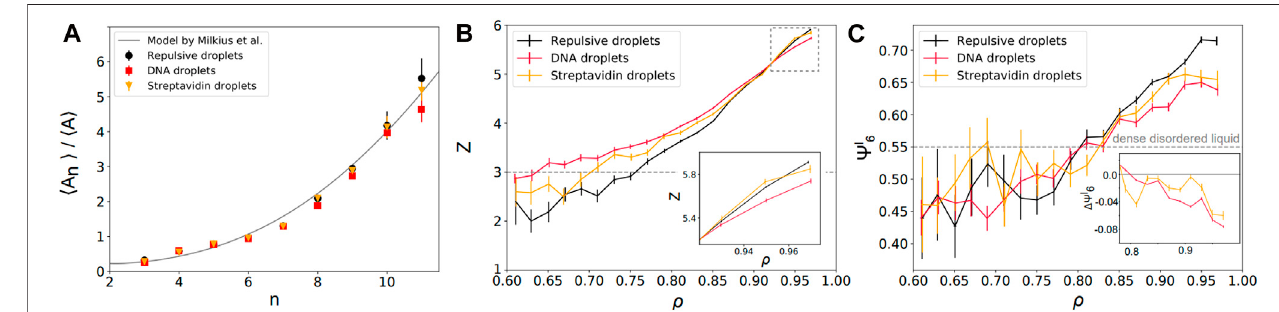
FIGURE3| Localstructuralpropertiesofstaticpackings — (A) AverageareaoftheVoronoicellsasafunctionoftheirnumberofneighbors n .Repulsive(blackdisks) and adhesive emulsions (DNA: red squares; streptavidin: yellow triangles) agree with the theoretical predictions of a granocentric model (black line) [70]. (B) Mean local dropletcoordinationnumber z asafunctionoftheirlocalpackingfractionsforrepulsive(black)andadhesivepackings(DNA:red;streptavidin:yellow).Inset:zoomathigh packing fractions near con fl uence. (C) Mean local bond orientational order ψ l 6 in the emulsions as a function of the local packing fraction in repulsive emulsions (black), DNA functionalized (red) and streptavidin-biotin functionalized emulsions (yellow). The local bond orientational order does not increase as much in adhesive emulsions at high packing fractions. Inset: Difference between adhesive droplets (DNA functionnalized in red, streptavidin-biotin functionnalized in yellow) and the